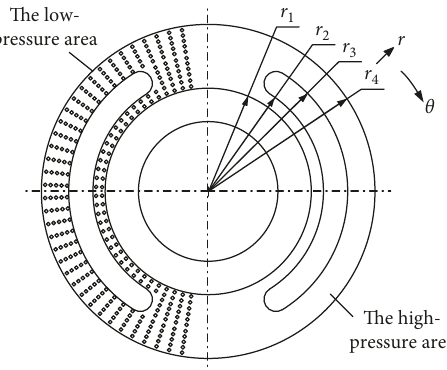
Figure 1: Textured port plate